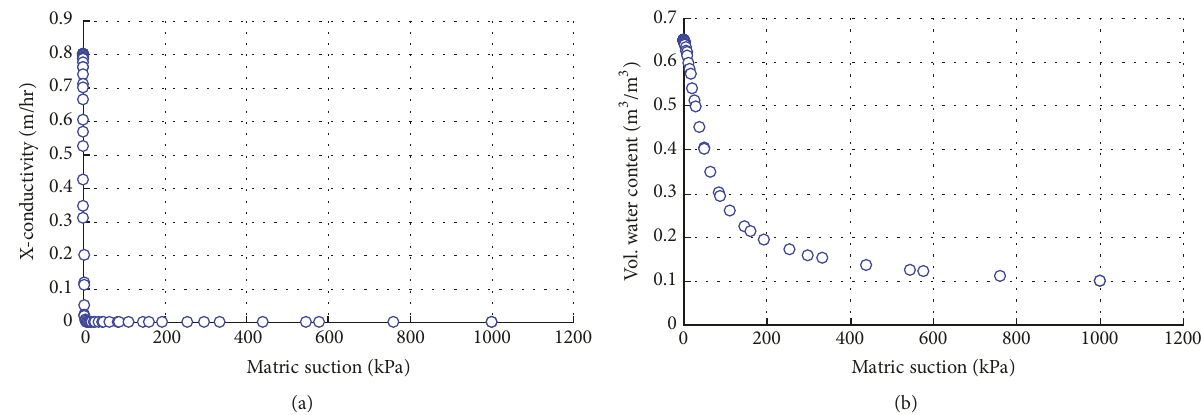
Figure 13: Permeability coefficient (coarse material): (a) matric suction versus conductivity and (b) matric suction versus water content.